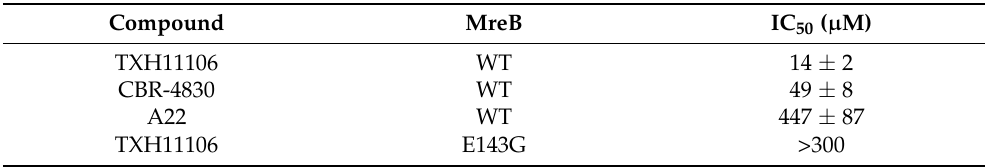
Figure 5. ( A ) Impact of increasing concentrations of TXH11106, CBR-4830, or A22 on the velocity of the ATPase reaction of wild-type (WT) E. coli MreB (EcMreB). Each experimental data point represents an average of two replicates, with the indicated error bars reflecting the standard deviation from the mean. The solid curves represent nonlinear least squares fits of the experimental data points with Equation (1). ( B ) Eadie–Hofstee plots of the ATP-dependent catalytic activity of WT EcMreB in the presence of DMSO vehicle or 30 µM inhibitor (TXH11106, CBR-4830, or A22). Each experimental data point represents an average of 3 replicates, with the indicated error bars reflecting the standard deviation from the mean. The solid lines represent linear fits of the experimental data points. Table 3. IC 50 values for inhibition of the ATPase activity of wild-type (WT) and E143G mutant EcMreB.